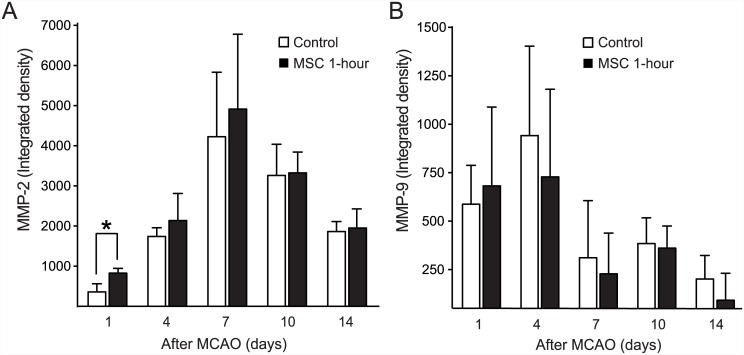
MMP-2 and -9 activities in the Ischemic Hemisphere.The MMP-2 activity in the MSC 1-hour group was significantly higher only at day 1 after IV infusion. Although remains higher subsequently, it did not remain statistically significant (A). By contrast, MMP-9 activity in the MSC 1-hour group was not significantly different from that in the control group. The increased MMP activities measured after MCAO decreased starting from 10 days (MMP-2) and 7 days (MMP-9) (B).